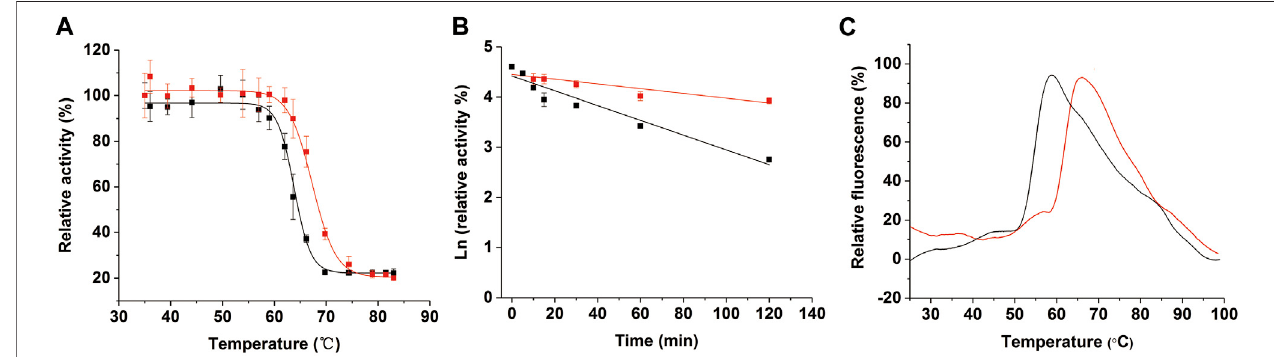
FIGURE 4 | Thermal stability of CjLPMO10A cd (black) and M1 (red). (A) Thermal inactivation of CjLPMO10A cd and M1 incubated at different temperatures for 15 min.Proteinsin50 mMTris-HClbuffer,pH7.8wereincubatedatvarioustemperaturesfor15 minandassayedforresidualactivityat30 ° C.Theactivityofthesamples without incubation was considered to be 100%. (B) Thermal inactivation of CjLPMO10A cd and M1 at 60 ° C. Proteins were incubated at 60 ° C and sampled at regular intervals to determine residual activity at 30 ° C. (C) Thermal unfolding of CjLPMO10A cd and M1 analyzed by DSF. The protein concentrations were 0.2 mg/ml, and the temperature was increased from 25 to 99 ° C with 0.05 ° C/s increment. All experiments were performed in triplicate.